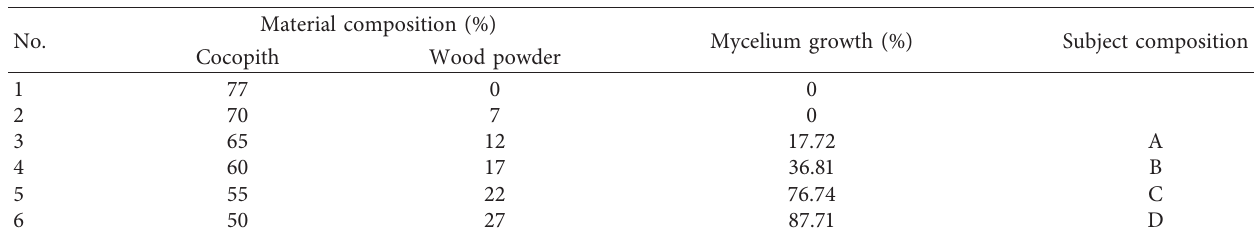
Table 3: Mycelium growth in baglog.